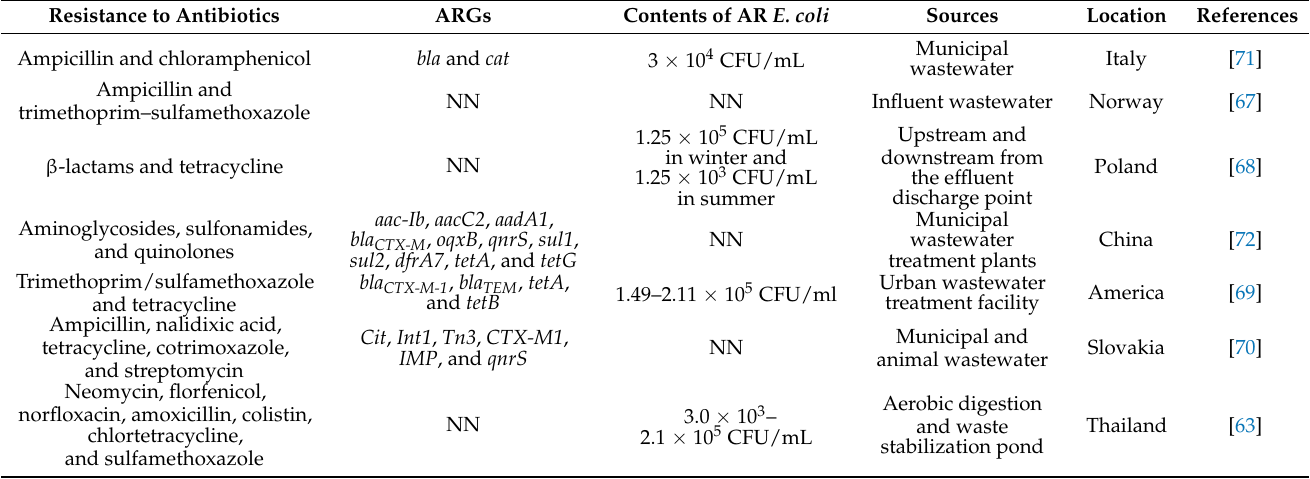
Table 3. AR E. coli and its ARGs in waste treatment plants